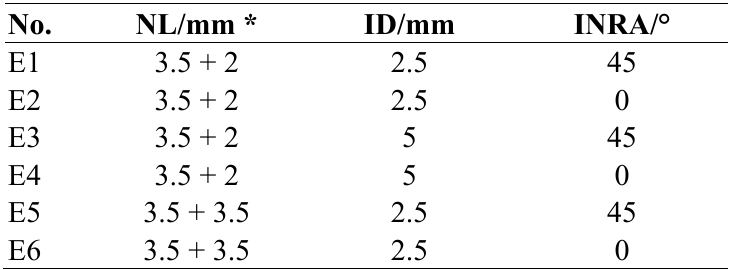
Table 1. Electrode configurations utilized in the current